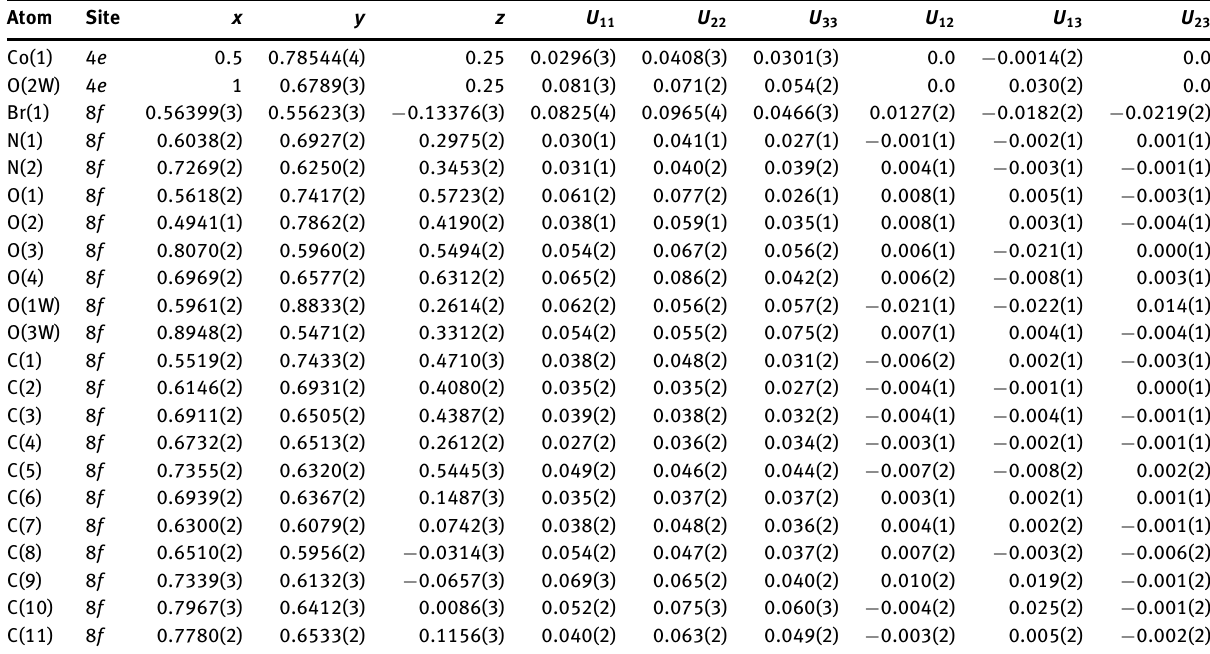
Table 3: Fractional coordinates and atomic displacement parameters (Å 2